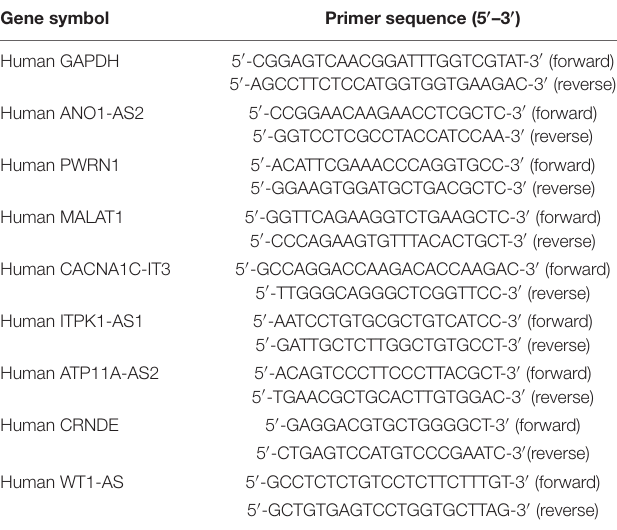
TABLE 1 | Primer sequence information for Real-time qPCR.